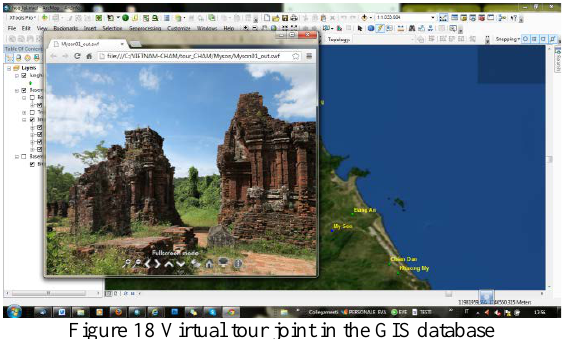
Figure 18 Virtual tour joint in the GIS